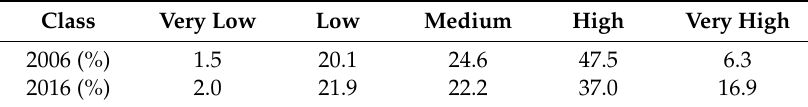
Figure 6. Groundwater vulnerability maps in 2006 ( a ) and 2016 ( b ). Table 6. Proportion of groundwater vulnerability areas in 2006 and 2016.